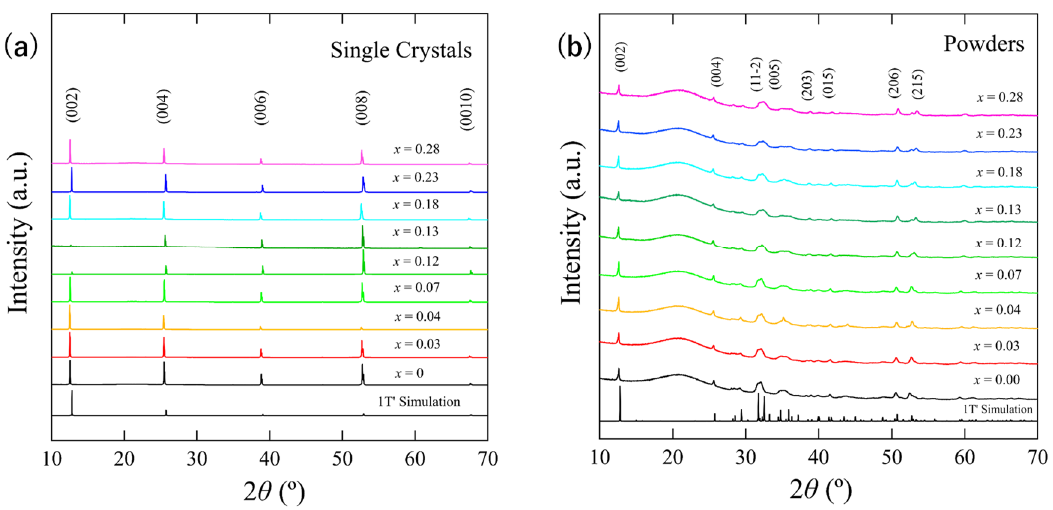
Figure 2. Results of XRD measurements of MoTe 2- x Se x samples with ( a ) single crystals and ( b ) powders. Simulation peaks were calculated using VESTA (version 3.4.4, Japan) [12] and crystal data were obtained from AtomWorks (http://crystdb.nims.go.jp/, accessed on 8 August 2019) [13]. The Se concentration ( x ) was obtained by EDX.